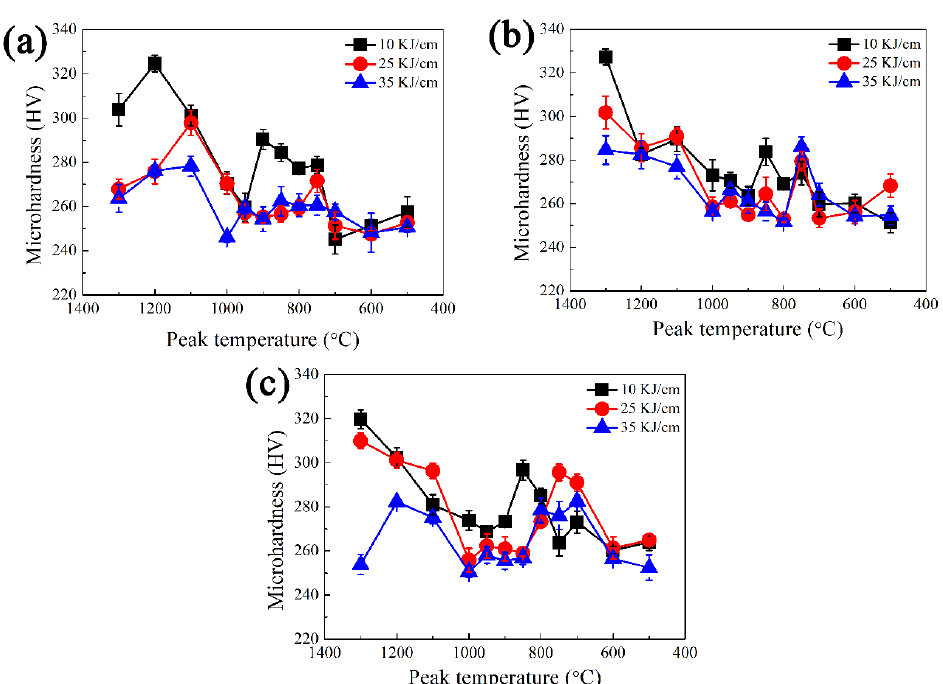
Figure 7. Effect of heat input on microhardness subjected to various peak temperatures and different Nb contents: ( a ) 1# − 0.062% Nb; ( b ) 2# − 0.089% Nb; ( c ) 3# − 0.112% Nb.